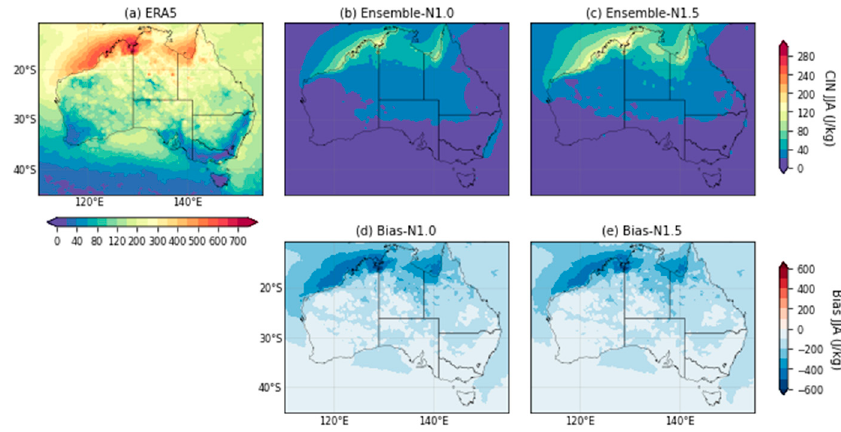
Figure A9. As in Figure A7 except for MAM.